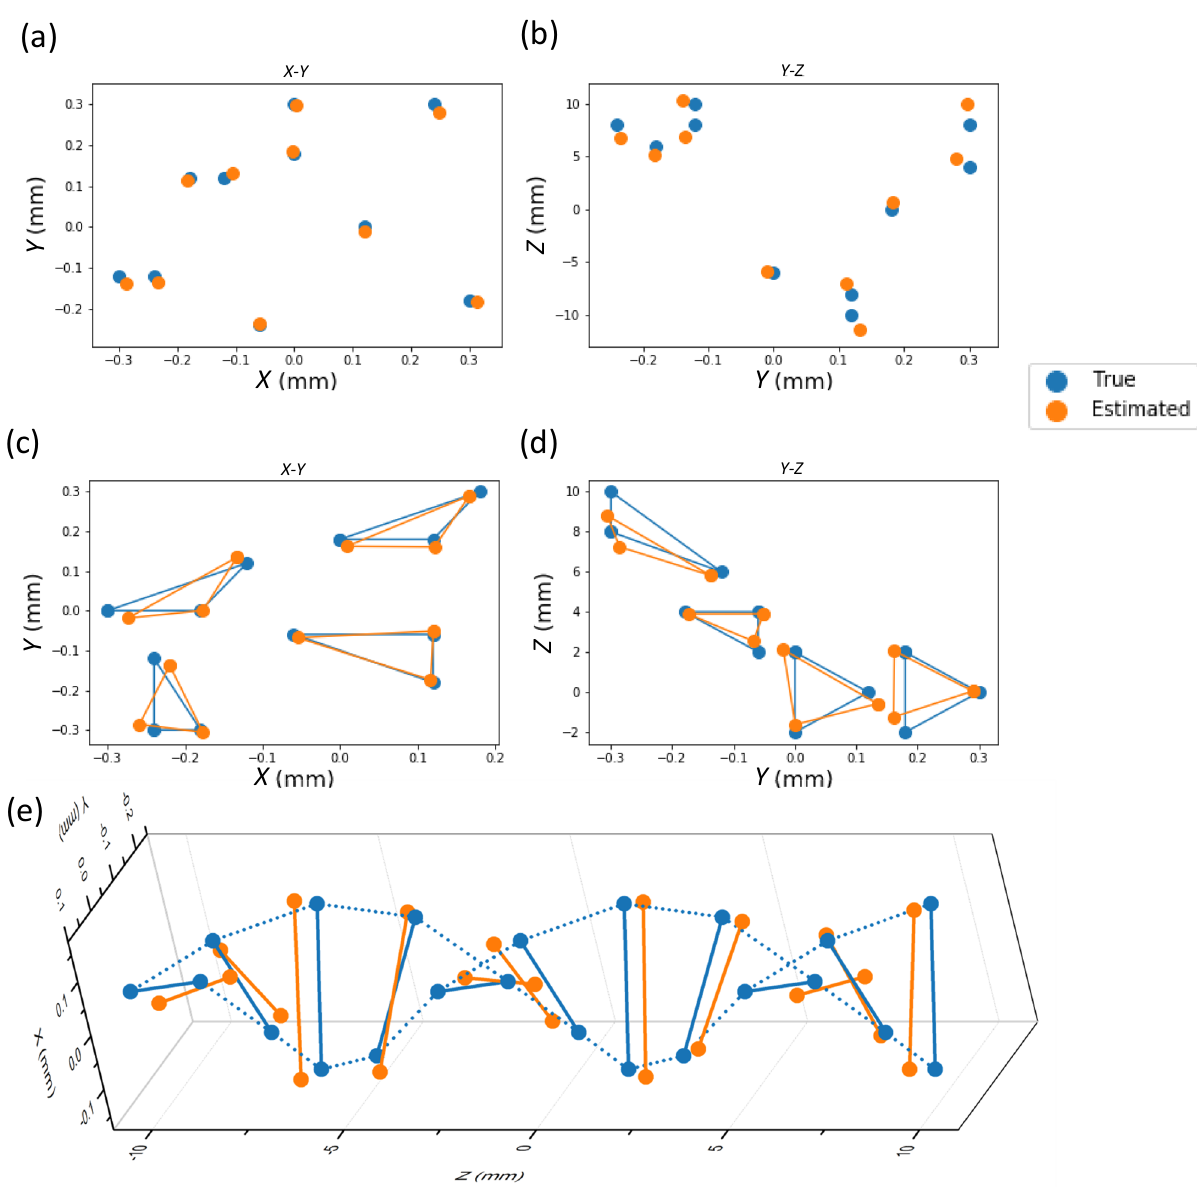
Fig. 3 3D point object tracking using focal stack data for three different types of point objects. a , b Tracking results for single point object (only 10 test samples are shown). Results are based on images captured with the graphene photodetector arrays. c , d Tracking results for three-points objects (only 4 test samples are shown). Results are based on data synthesized from multi-focal-plane CMOS images (downsampled to 9 × 9) of single point source. e Tracking results for rotating two-point objects on one testing trajectory. The object is rotating counter-clockwise (viewed from left) while moving from z ¼ (cid:2) 10mm to z ¼ 10mm. Results are based on data synthesized from single point source images captured with graphene photodetector arrays.